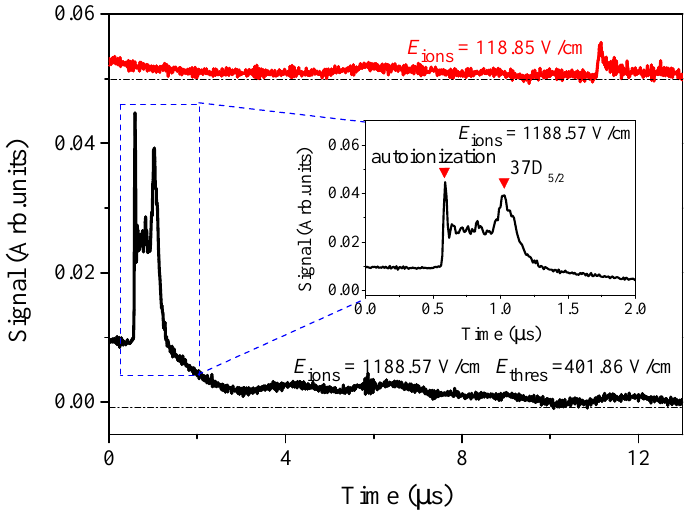
Figure 2. Time of flight (TOF) of the two-photon spectroscopy for the laser excitation to 37 D 5/2 Rydberg state. The red upper line displays the TOF spectrum for the field E ion < E thres (the baseline of the red curve is offset to discern the signals.) The black lower line represents the TOF spectrum for the field E ion > E thres . The ionization threshold value E thres of the 37 D 5/2 Rydberg state is 401.86 V/cm. The inset is an enlargement of the signals in the blue dashed